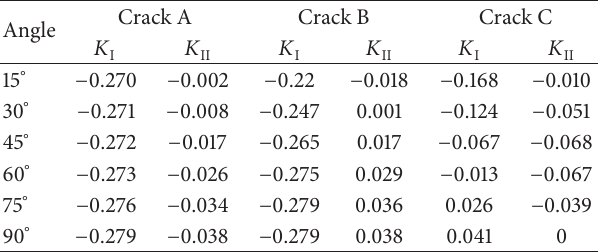
Table 1: Calculation results of SIF (MPa ∗ m 1/2 ) from ABAQUS